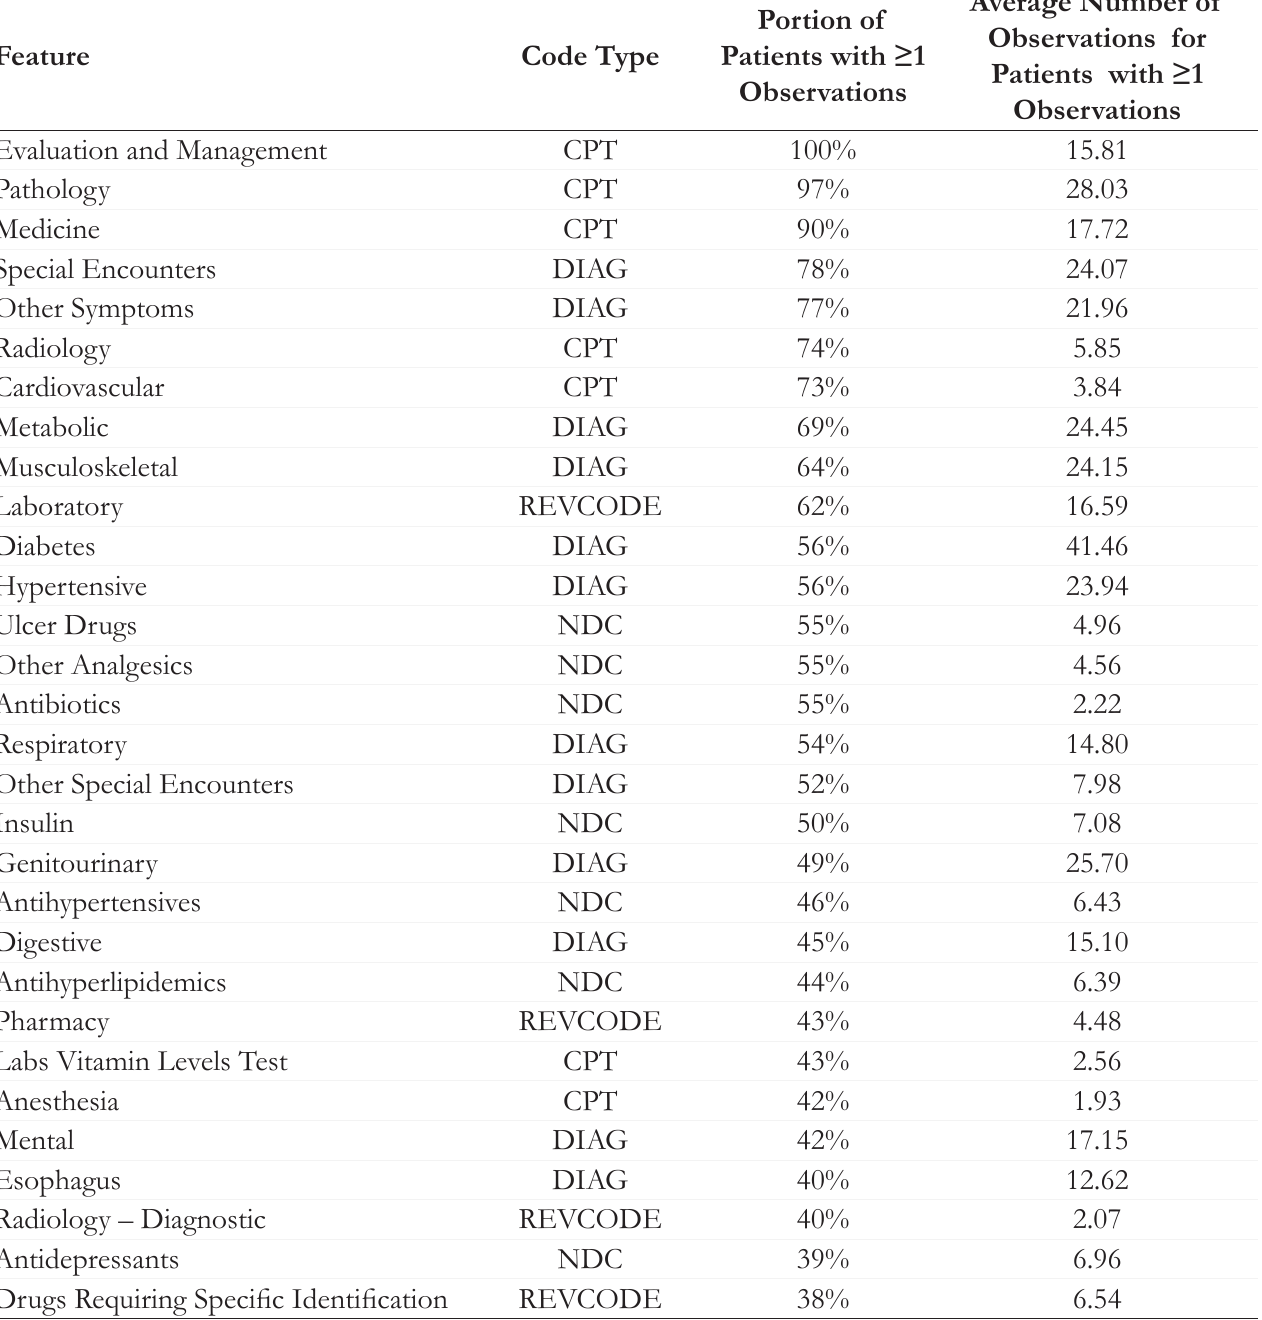
Table 6a. Most Frequent Features in Patients with 10% to 20% EPI